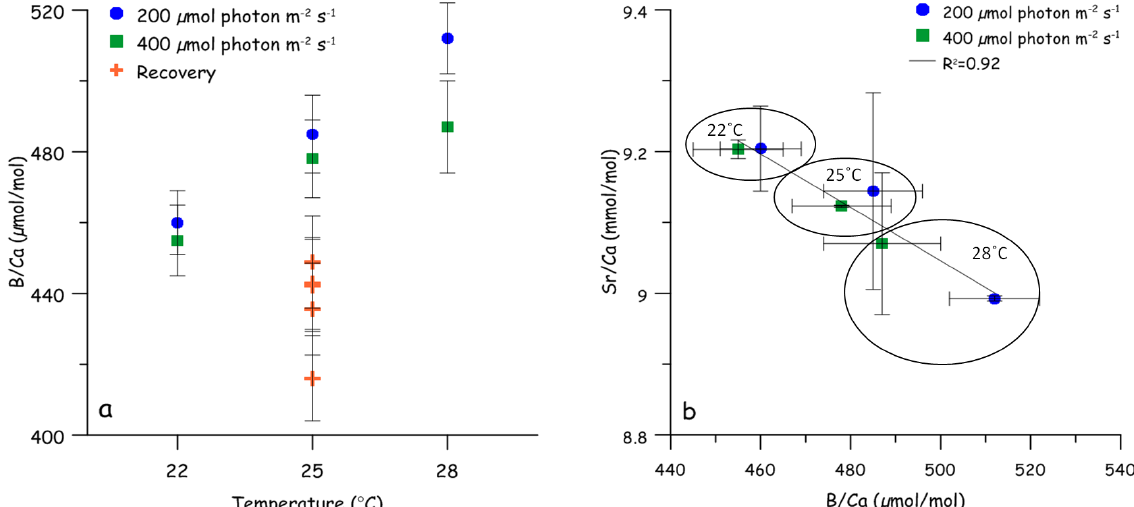
Fig. 5. (a) Mean B/Ca ratios (µmolmol − 1 ) measured at the end of step 2 on corals grown under 200 (blue dots) and 400 (green squares) photonm − 2 s − 1 , plotted vs. temperature. Measurements performed after step 3 (recovery experiment) are plotted on the same graph (orange crosses). (b) . Mean B/Ca ratios plotted vs. mean Sr/Ca ratios measured simultaneously (200 and 400photonm − 2 s − 1 light conditions are represented by blue dots and green squares, respectively). Solid lines represent linear regression calculated using all values ( R 2 = 0 . 92). Interpretation of the Sr/Ca values will be presented elsewhere (Juillet-Leclerc et al.,